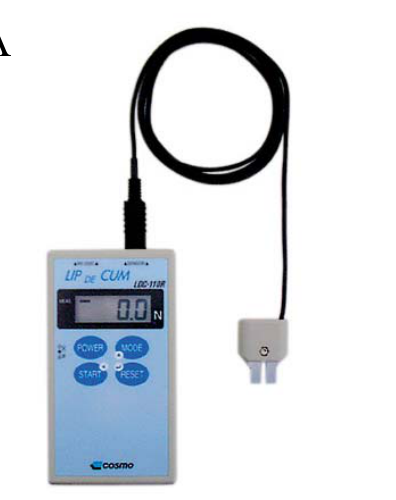
Figure 2. Commercially available lip-force measuring devices. A: LIP DE CUM (left). B: Beauty Health Checker (right). (Photos courtesy of Cosmo Instruments and